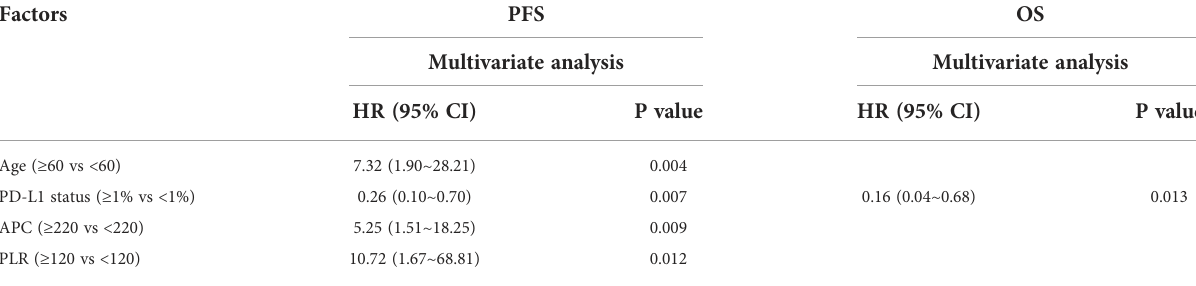
TABLE 2 Estimates for hazard ratios for progression-free survival and overall survival in the pembrolizumab group. Factors PFS OS Multivariate